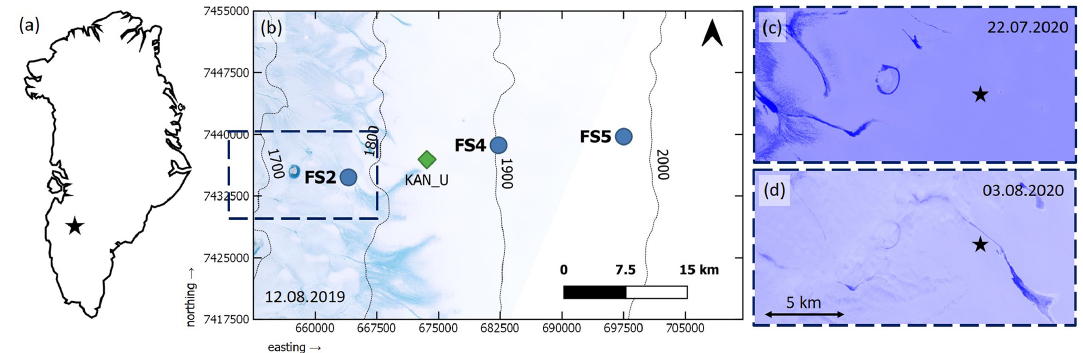
Figure 2. (a) Overview map of Greenland, with the black star indicating the approximate field site location. (b) Map of the study area, showing the various field sites (FS2 for summer measurements; FS4 for spring data collection; FS2, FS4 and FS5 for firn stratigraphy and KAN_U for meteorological data). Thin black lines represent elevation contours from the ArcticDEM modified to show elevation (in ma.s.l.). (Porter et al., 2018). The background image is a Sentinel-2 true colour composite from around the time of maximum melt extent in 2019. The dashed dark blue rectangle indicates the outline of the composites shown in panels (c) and (d) . (c) Sentinel-2 Normalized Difference Water Index (NDWI) composite showing the liquid water presence (in dark blue) on the ice sheet surface on 22 July 2020. (d) Sentinel-2 NDWI composite showing the liquid water presence on the ice sheet surface, again in dark blue, on 3 August 2020. Note that the surface meltwater in the lower areas is masked by the presence of clouds. For (c) and (d) , the black star indicates the location of field site FS2. For (b) , (c) and (d) , the source is Sinergise Ltd.